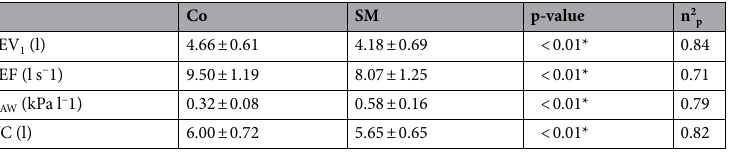
Table 1. Results of body plethysmography. The values are given as means and standard deviations. Co control; SM surgical mask; FEV p partial eta-squared. *Significant differences from the control.